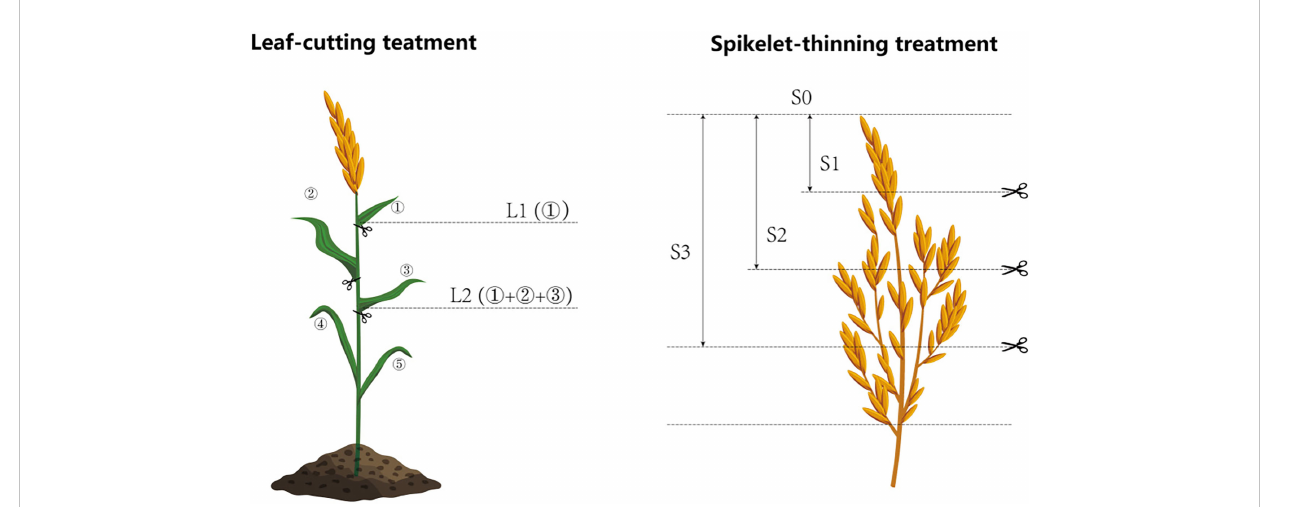
FIGURE 1 Schematic diagram of the treatment of leaf-cutting and spikelet-thinning. L0 represent the treatment of no leaf-cutting; L1 represent the treatment of cutting top of one leaf; L2 represent the treatment of cutting top of three leaves; S0, S1, S2 and S3 represent the treatment of thinning 0, 1/4, 1/2 and 3/4 spikelets,